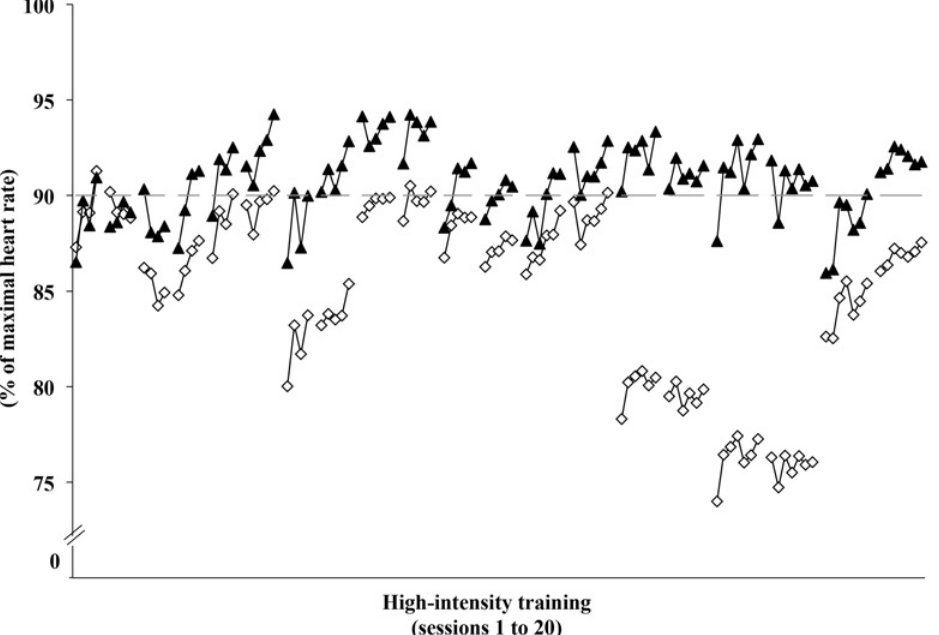
Fig 1. Repetition mean peak heart rates during the high-intensity interval training sessions. ▲ represent the PP data; (cid:4) represent the ITT data; ── indicates our threshold for high-intensity [90%HRmax]. Error bars have been omitted for figure